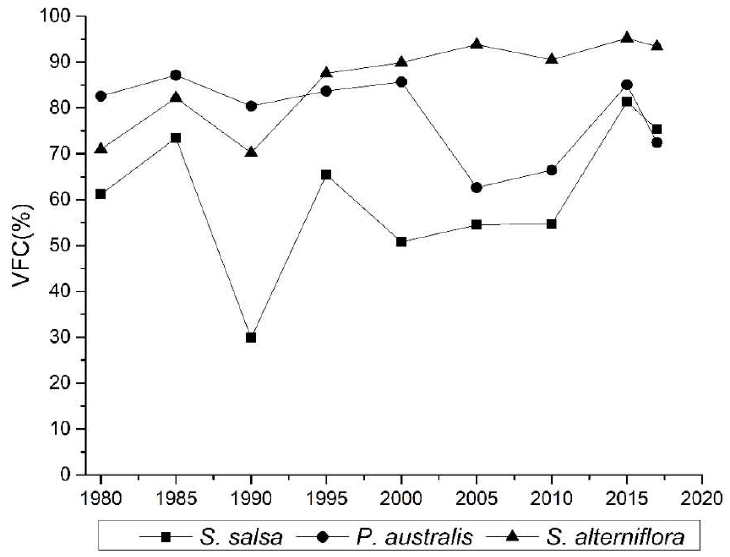
Figure 6. Inter-annual variations in vegetation coverage.